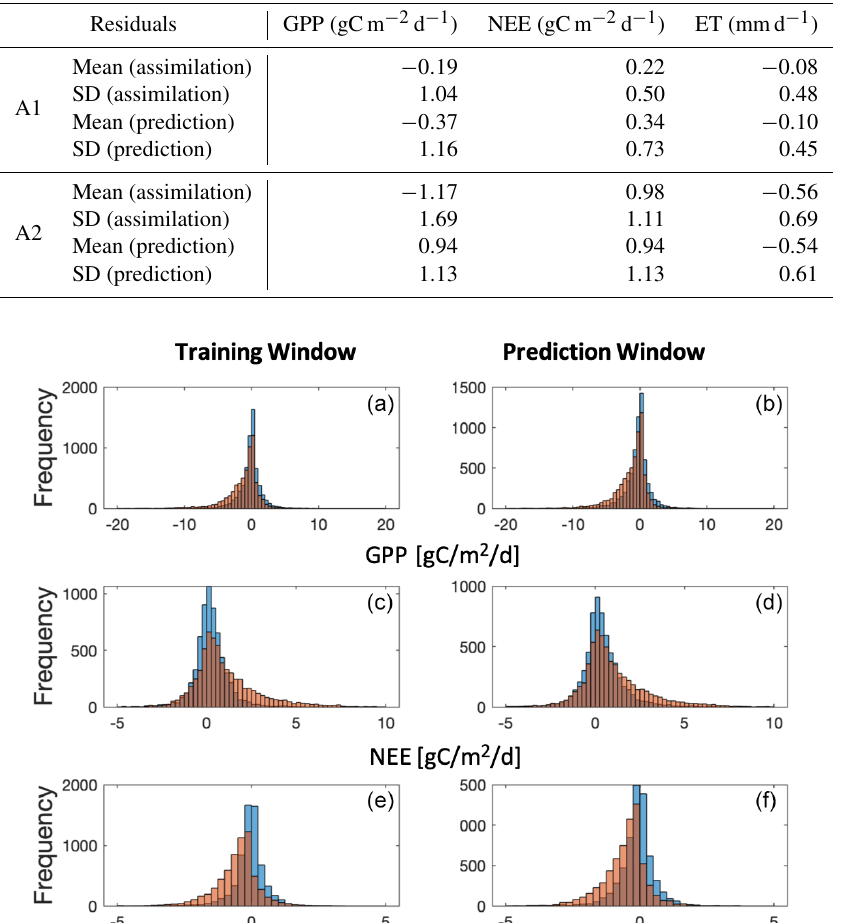
Table 2. Annual-based residuals in assimilation and prediction windows (Fig. 2).